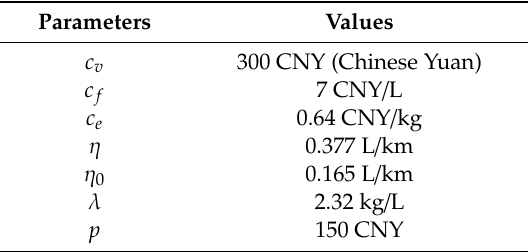
Table 11. Parameters of the proposed CVRP